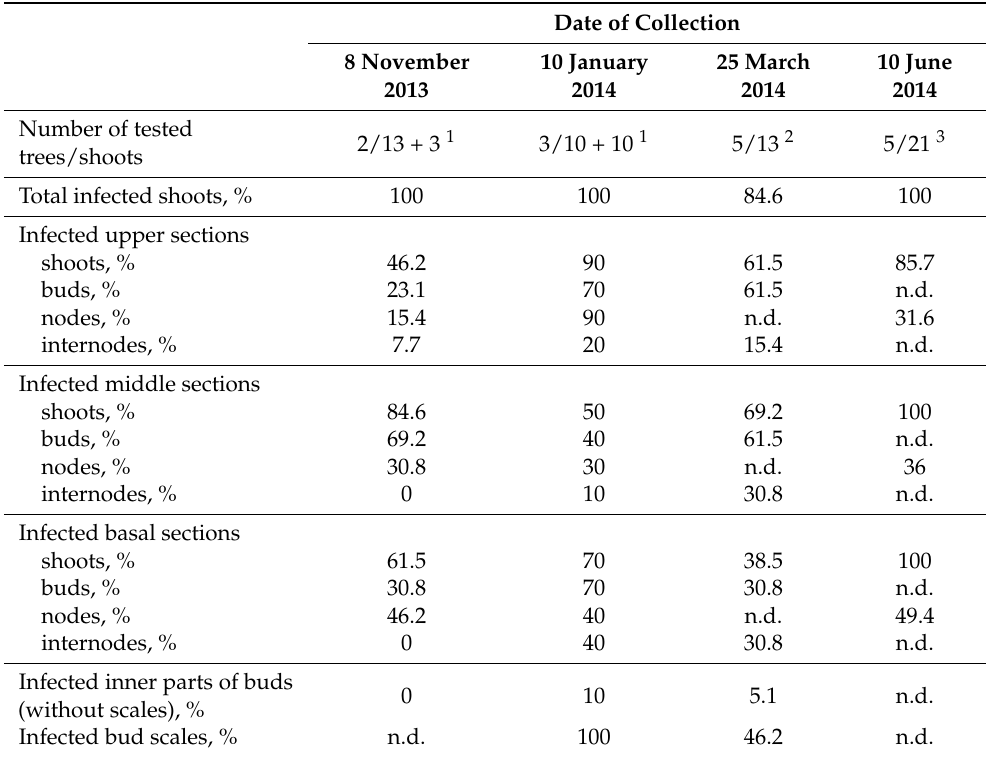
Table 2. Fungal colonization of the dormant annual twigs (November–March) and the newly grown shoots (June) of the Manchurian apricot in